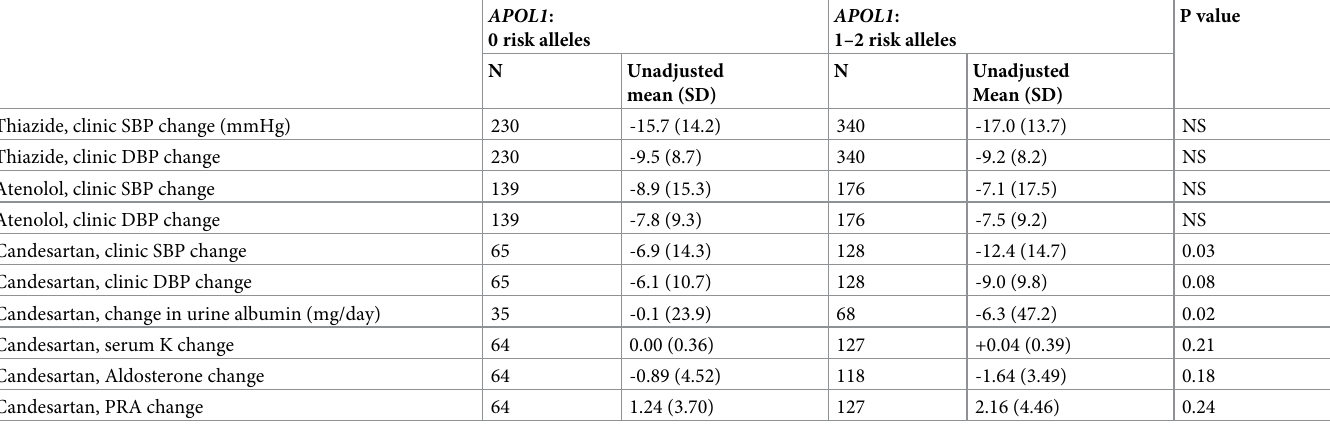
Table 4. Changes with blood pressure drugs by APOL1